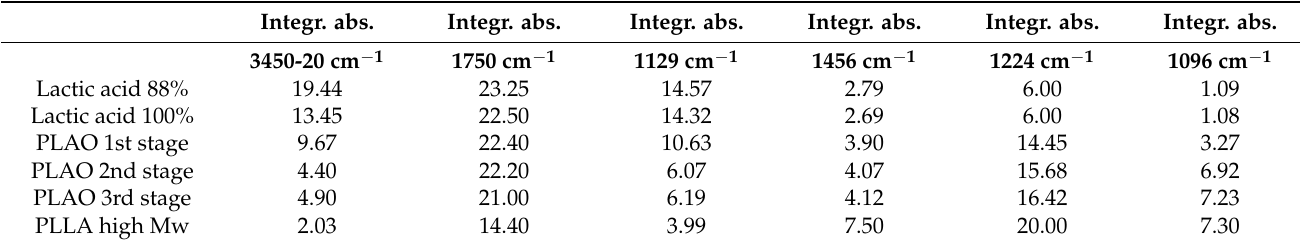
Table 1. Integrated absorptivity of selected infrared bands of Lactic Acid, PLAO, and PLLA. Integr. abs. Integr. abs. Integr. abs. Integr. abs. Integr. abs. Integr.